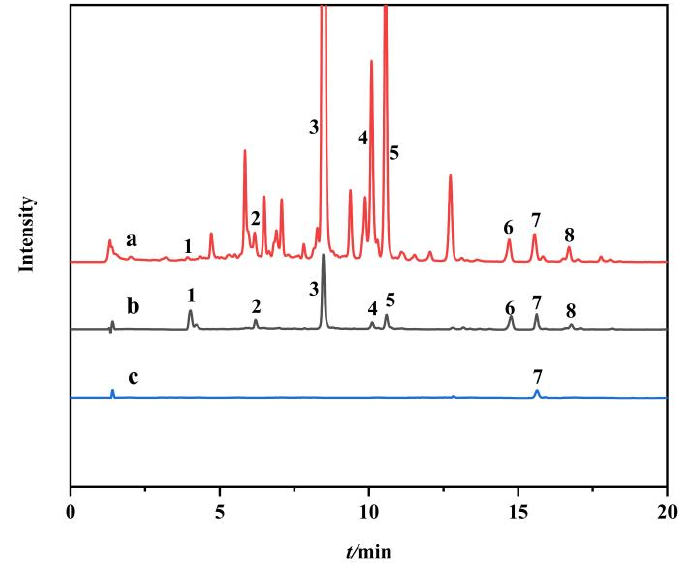
Figure 8. UPLC-Q-TOF-MS/MS diagrams of the water solution of S. baicalensis ( a ), the methanol eluent of the ligand fishing by Fe 3 O 4 -COOH@UiO-66-NH 2 @PPL ( b ), and methanol eluent of the ligand fishing by blank MMOFs ( c ).